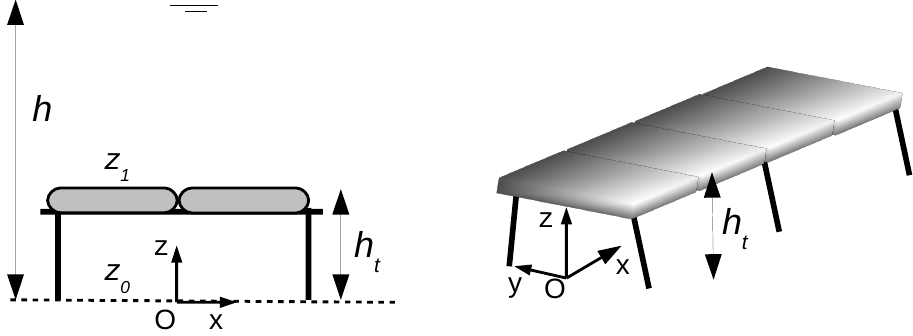
Figure 3. Schematic representation of oyster